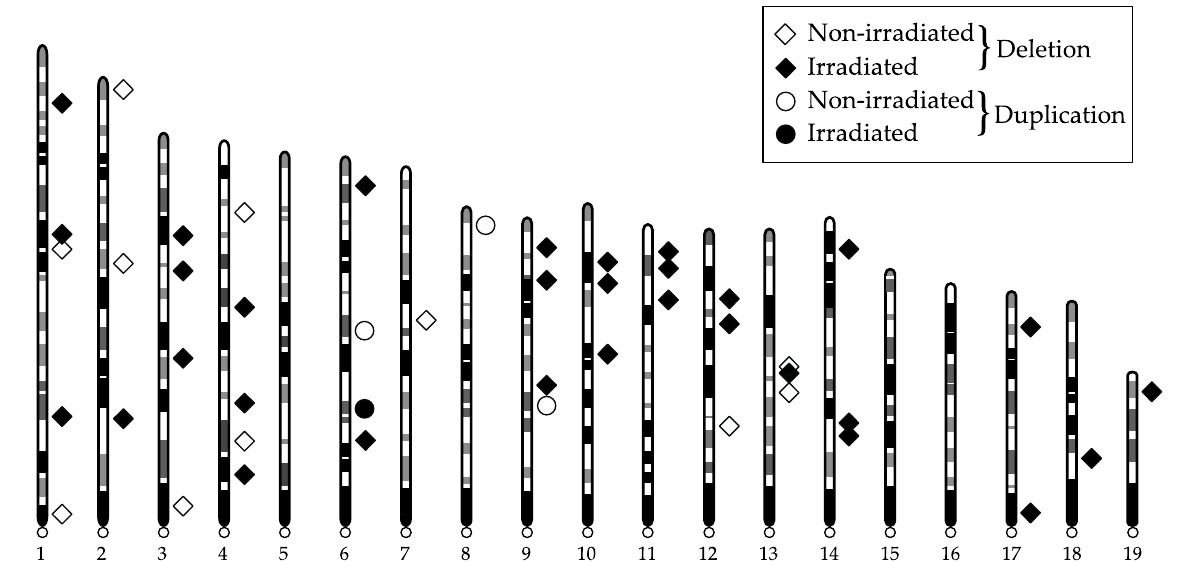
Figure 3. Chromosomal distribution of de novo CNVs.